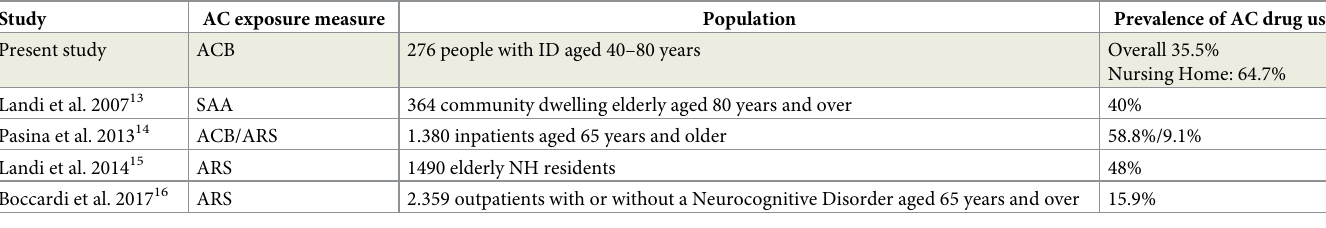
Table 4. Study Comparisons on prevalent AC exposure in Italian